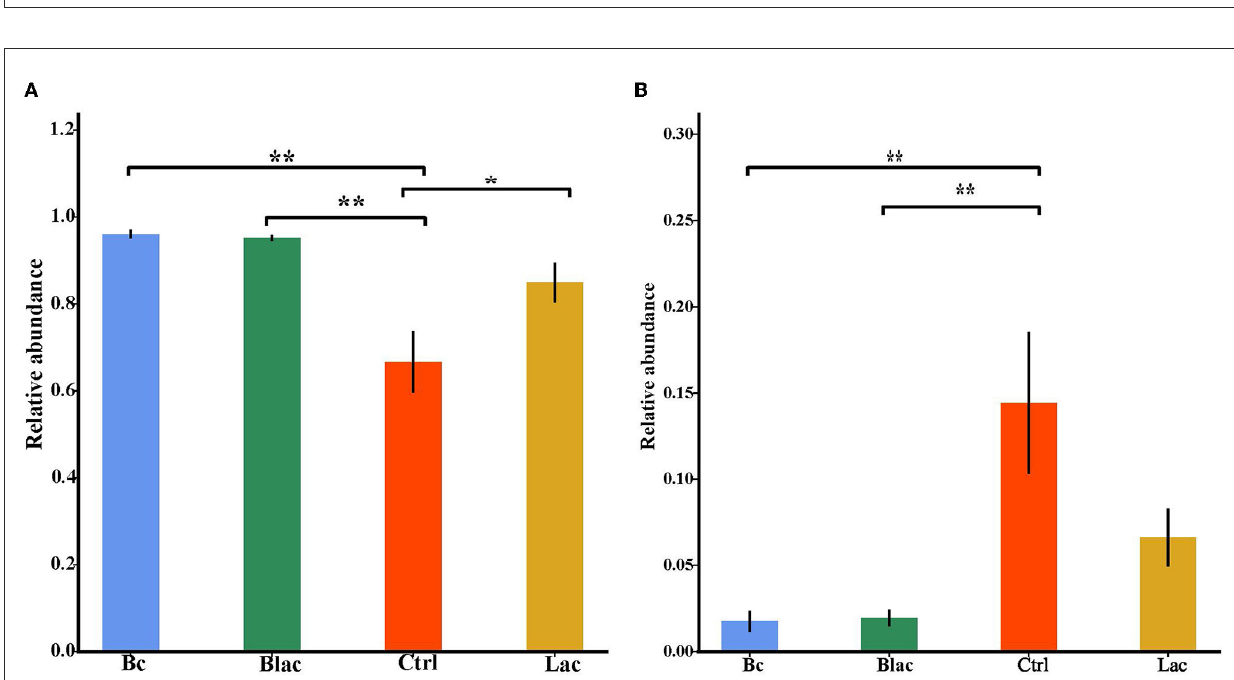
FIGURE6 Histogram of analysis of variance among groups at Lactobacillus level (A) and Erwinia level (B) ; *means significant difference ( P < 0.05); **means extremely significant difference ( P < 0.01); Bc, added with strain B. cereus AH7-7; Blac, added with strain B. cereus AH7-7, Lactobacillus plantarum and Lactobacillus buchneri ; Lac, added with Lactobacillus plantarum and Lactobacillus buchneri ; Ctrl, no